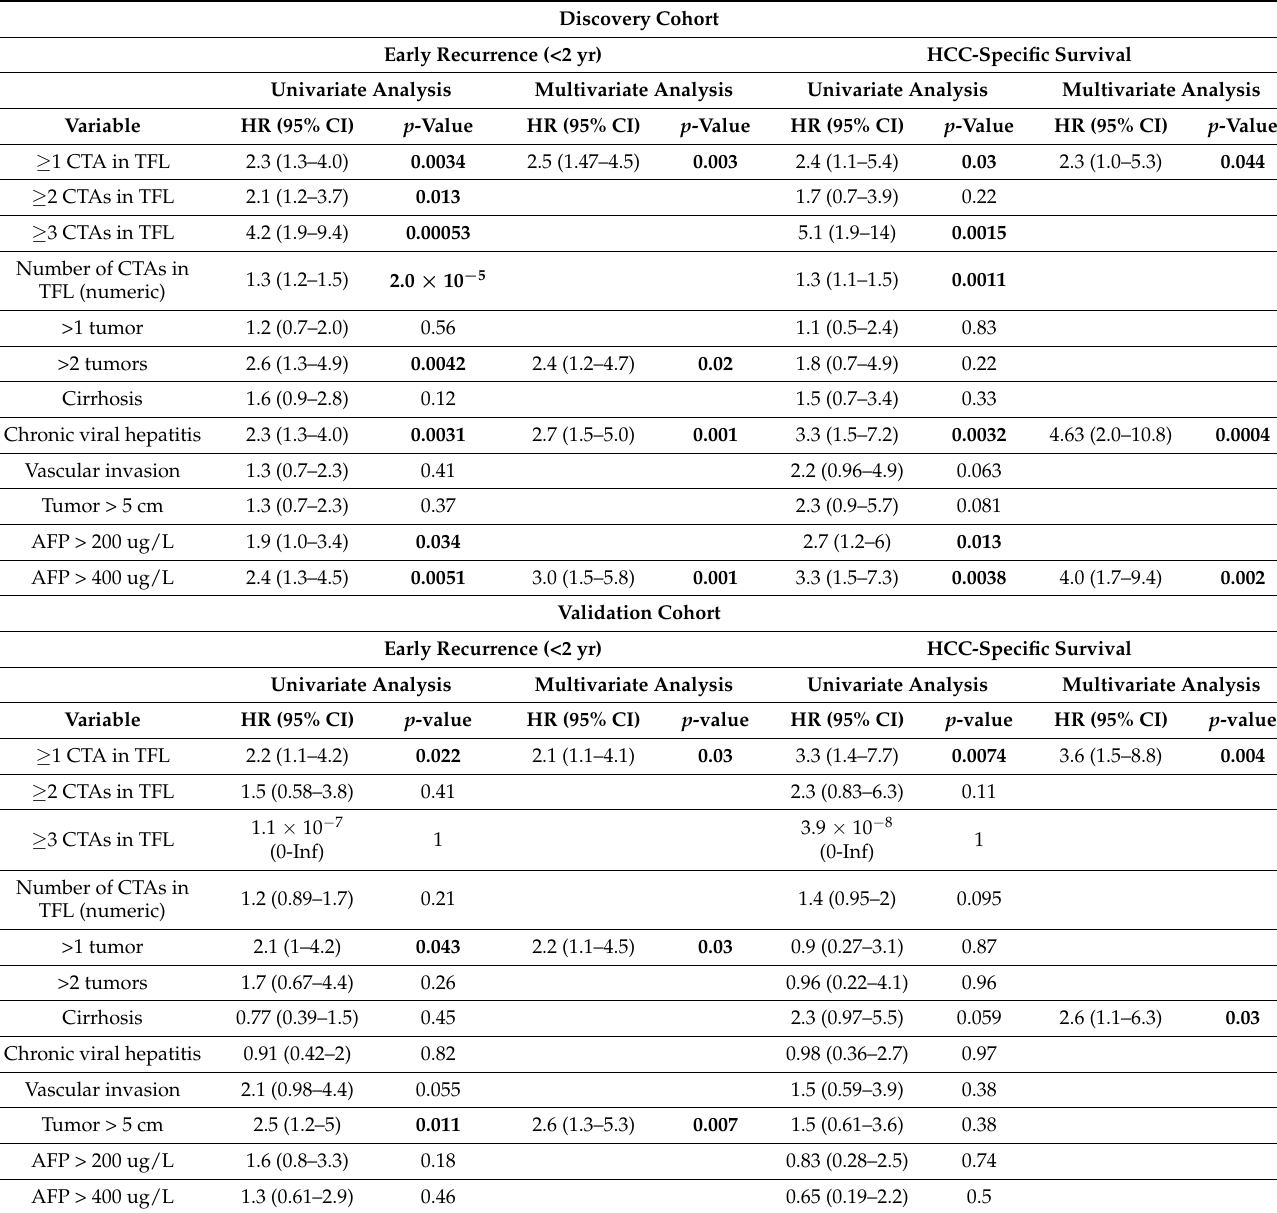
Table 2. CTA mRNA-expression in TFL is an independent prognostic factor of HCC recurrence and HCC-specific survival. Univariate and multivariate analyses of factors associated with recurrence and survival according to the cox proportional hazard model. Abbreviations: AFP, alphafoetoprotein; 95% CI, 95% confidence interval; CTA, cancer testis antigen; HR, hazard ratio; TFL, tumor-free liver. Significant values ( p < 0.05) are indicated in